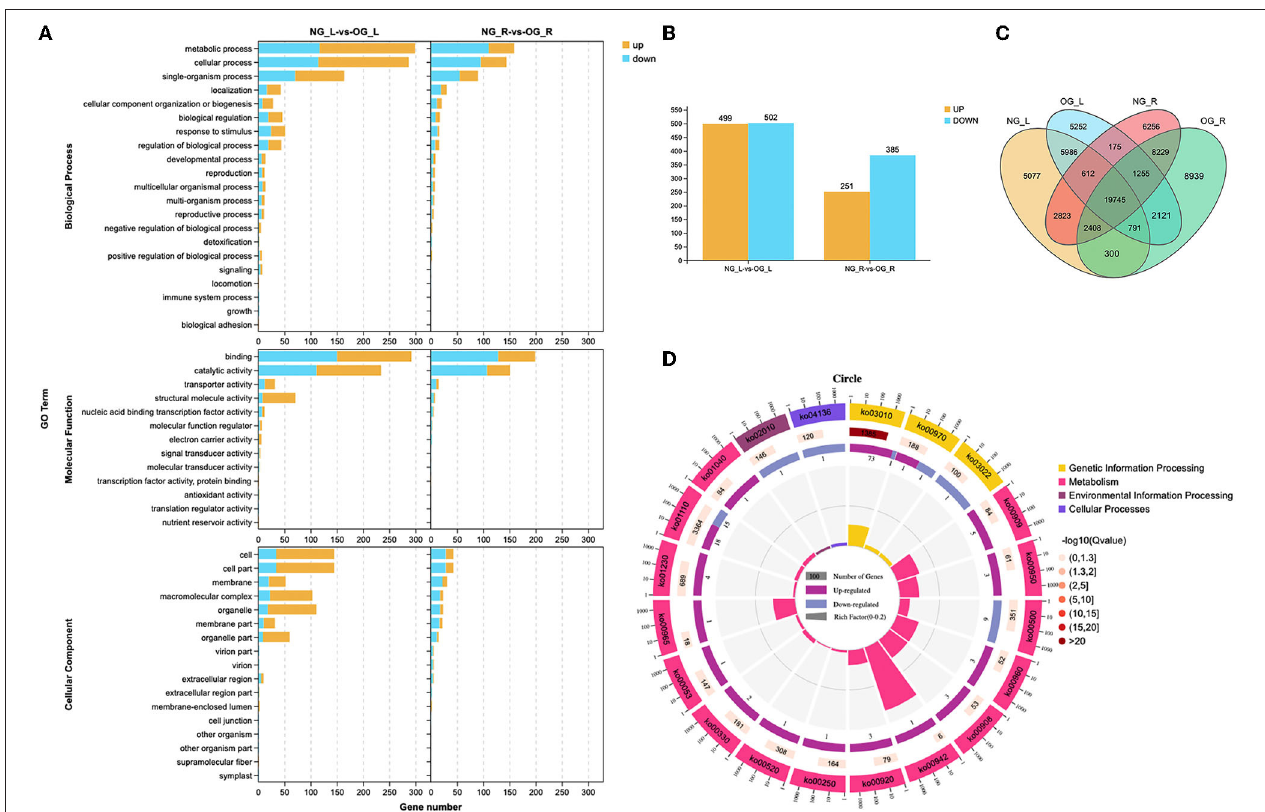
FIGURE 3 | Differences between the NG and OG plants at the transcriptome level. (A) Gene ontology (GO) enrichment maps of differentially expressed genes (DEGs). (B) Number of DEGs between NG and OG plants. (C) Venn diagram of all genes between the leaf and root. (D) Kyoto Encyclopedia of Genes and Genomes (KEGG) enrichment maps of DEGs. NG_L, leaf of no-grazing plants; NG_R, root of no-grazing plants; OG_L, leaf of overgrazing plants; OG_R, root of overgrazing plants.